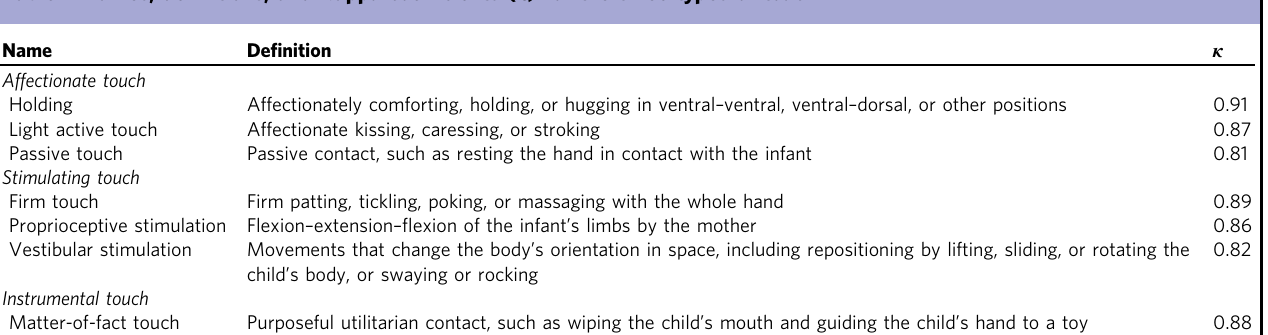
Table 2 Names, de fi nitions, and Kappa coef fi cients ( κ ) for the three types of